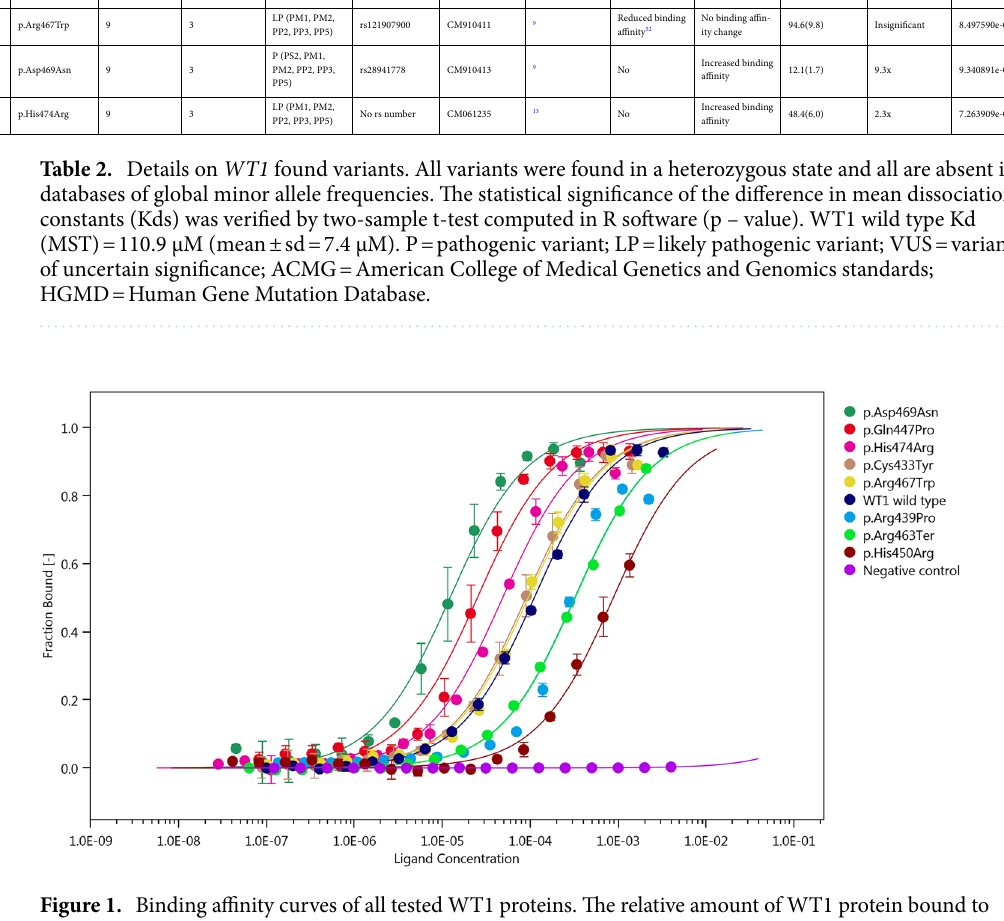
mutants (p.Cys433Tyr and p.Arg467Trp) the analysis did not reveal a statistically significant difference in the binding affinity compared to the wild type WT1 protein. The group of patients studied was too heterogeneous to perform any analyses exploring the association between binding affinity and clinical phenotype. There was no apparent segregation of distinct clinical phenotypes of the cases based on the DNA-binding affinity of WT1 mutants. To improve our understanding of the link between the DNA-binding affinity of WT1 mutants and the expression of target genes, we performed reporter luciferase assay. Actin gene ( ACTN1 ) was identified to be abundantly expressed in kidney according to Human Protein Atlas (https:// www. prote inatl as. org/ ENSG0 00000 72110- ACTN1/ tissue) and also contains WT1-specific binding site in its promoter, very close to the transcrip- tion start site 8 , thus posing a feasible target gene. Two representative WT1 mutants were selected (p.Gln447Pro and p.His450Arg, the highest and lowest binding affinity in the MST assay, respectively). The luciferase assay